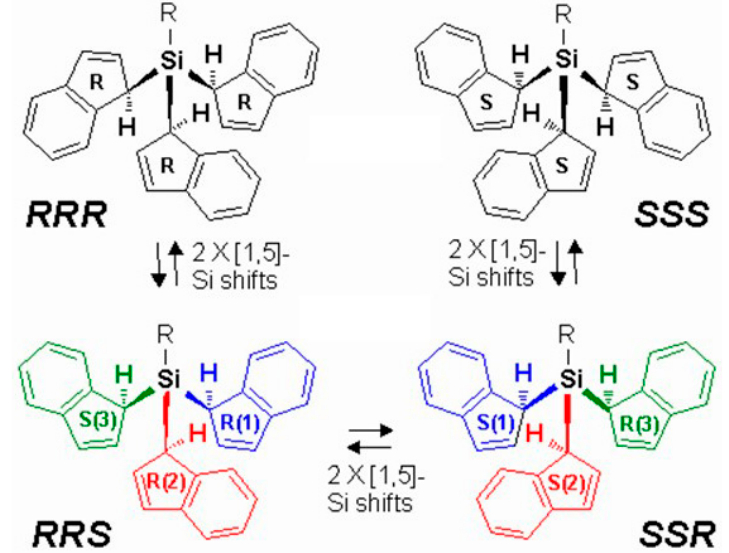
ring environments of